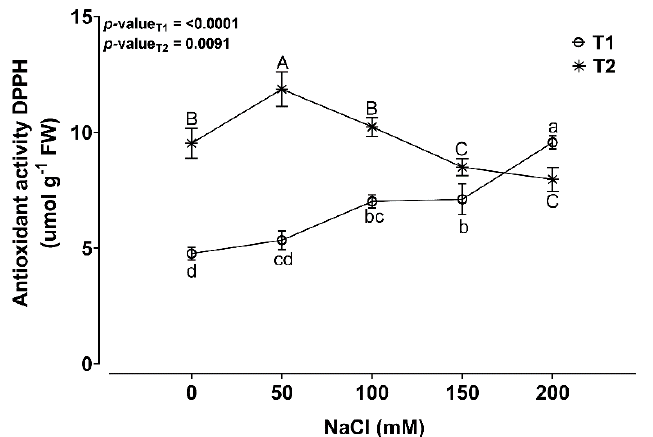
Figure 6. Antioxidant activity (DPPH) in red lettuce plants ( Lactuca sativa Lollo Rosso cv. ‘CARMOLI’) growing at different saline concentrations in a hydroponic system. T1: total phenols after 7 days of NaCl application. T2: total phenols after 15 days of NaCl application. Different letters indicate significant differences ( p < 0.05), according to the Tukey multiple range test ( p < 0.05) following ANOVA. Data are expressed as mean ± SE, n = 6.